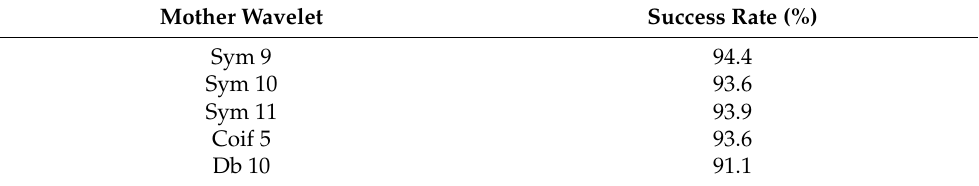
Table 3. Success rate of the classification system (KNN-cosine) for each mother wavelet. Mother